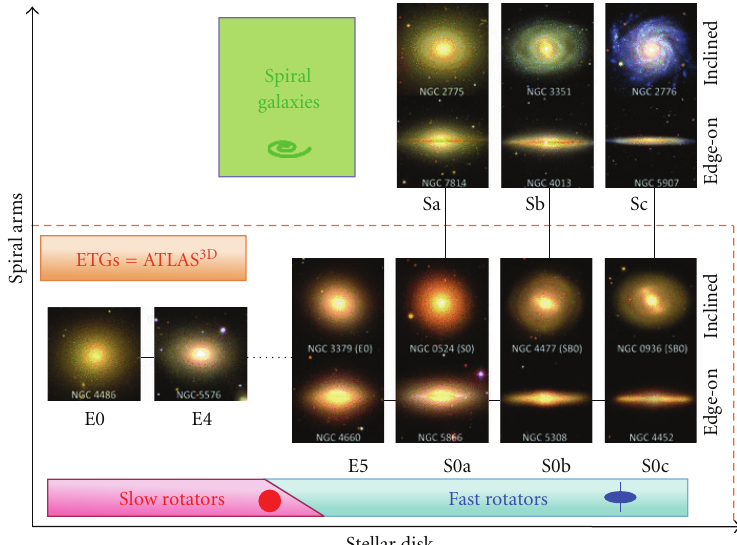
Figure 3: Galaxy classification scheme proposed by the ATLAS 3D project. Galaxies are classified as fast and slow rotators. Fast rotators form a parallel sequence to spiral galaxies. Credit: Cappellari et al. [18]. Reproduced by permission from